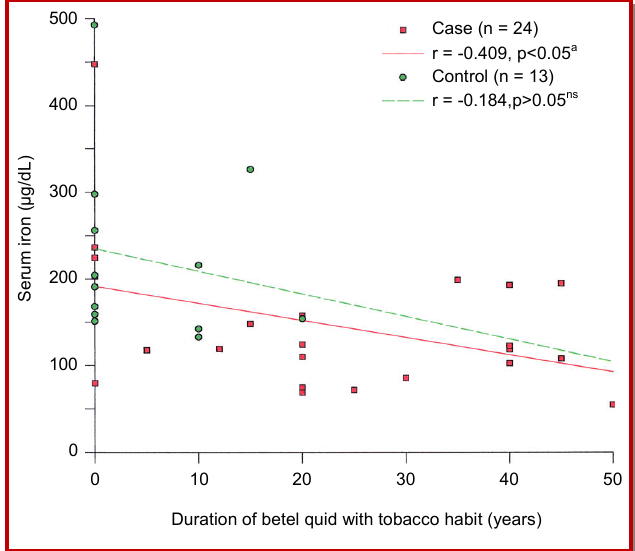
Figure 1: Relationship between serum iron concentration and duration of intake of betel quid with